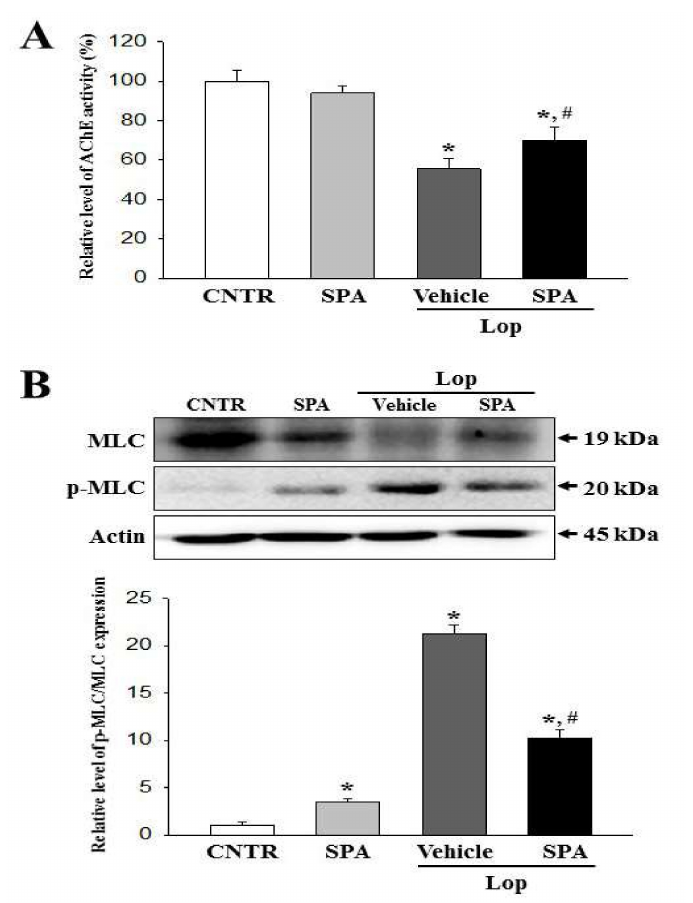
Figure 8. The AChE activity and myosin light chains (MLC) phosphorylation after SPA treatment: ( A ) The measurement of AChE activity. After the homogenization of the colon tissue, the AChE activity was measured using an Acetylcholinesterase Assay Kit. It can detect as little as 0.01 mU AChE in a 100 µ l assay volume (0.1 mU/mL). Five to six rats per group were used in preparation of the tissue lysate and AChE activity analysis were assayed in duplicate in each sample. ( B ) The detection of MLC phosphorylation: Expressions of MLC and p-MLC measured by western blot analyses using HRP-labeled secondary anti-rabbit IgG antibody and the relative levels of each protein were calculated relative to the intensity of actin bands. Five to six rats per group were used in the preparation of the protein homogenate and the western blot analysis were assayed in duplicate in each sample. The data are reported as the mean ± SD. * indicates p < 0.05 compared to the CNTR group. # indicates p < 0.05 compared to the Lop + Vehicle-treated